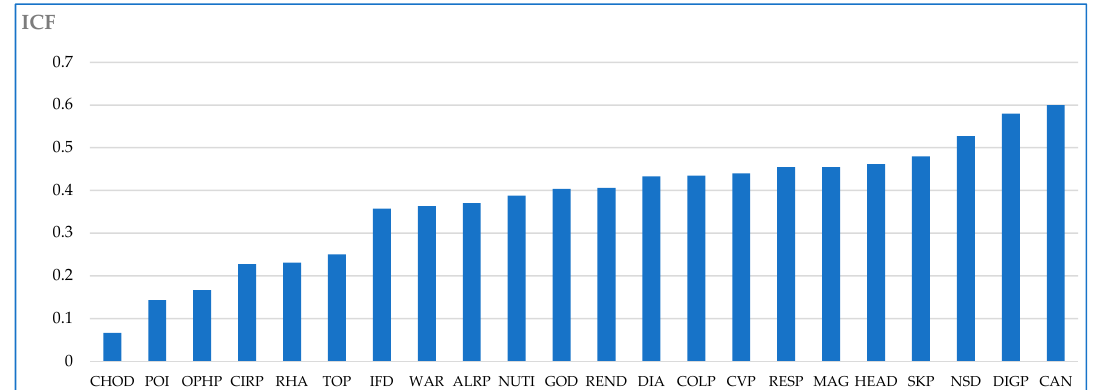
Figure 6. Informant Consensus Factor (ICF) in Eeastern Morocco by traditional healers. Table 5. Category of diseases, symptom, ICF, NUR (number of use citations in each ailment), NT (number of species used for this ailment).